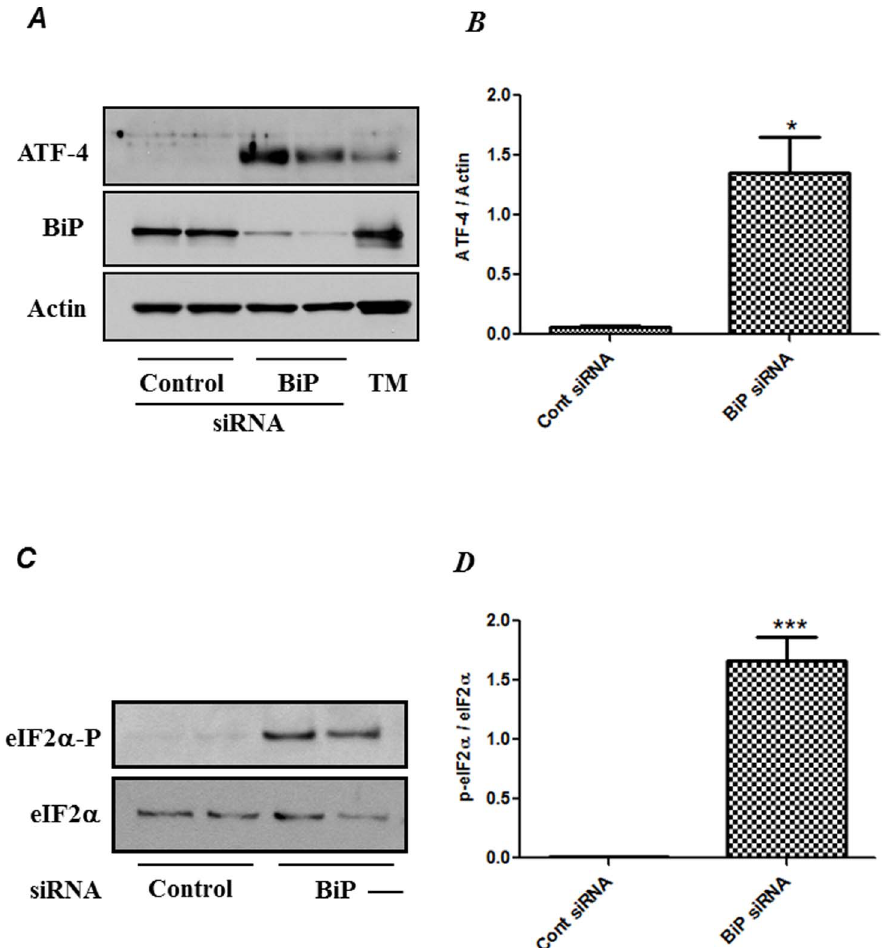
Figure 1. BiP knockdown induces ER stress. HPAEC were transfected with control siRNA or BiP siRNA for 48 h using DharmaFect1. Total cell lysates were separated by SDS-PAGE and immunoblotted with ( A ) anti-ATF4 antibody, and anti-actin antibody were used to monitor loading and anti-BiP antibody was used to monitor depletion and with ( C ) anti-phospho-eIF2 a and anti-eIF2 a antibody. TM, tunicamycin was used as a positive control. The data are the means 6 S.E. (n=3–6 for each condition). The bar graph represents the effect of BiP depletion on ( B ) ATF-4 expression and ( D ) eIF2- a phosphorylation, normalized to actin level. The data are the means 6 S.E. (n=3–6 for each condition). * p , 0.01 or *** p , 0.001 difference from controls.